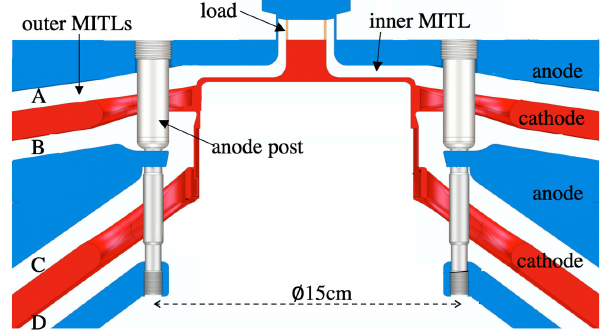
1. A cross section of the Z machine outer MITLs, ∅ 15